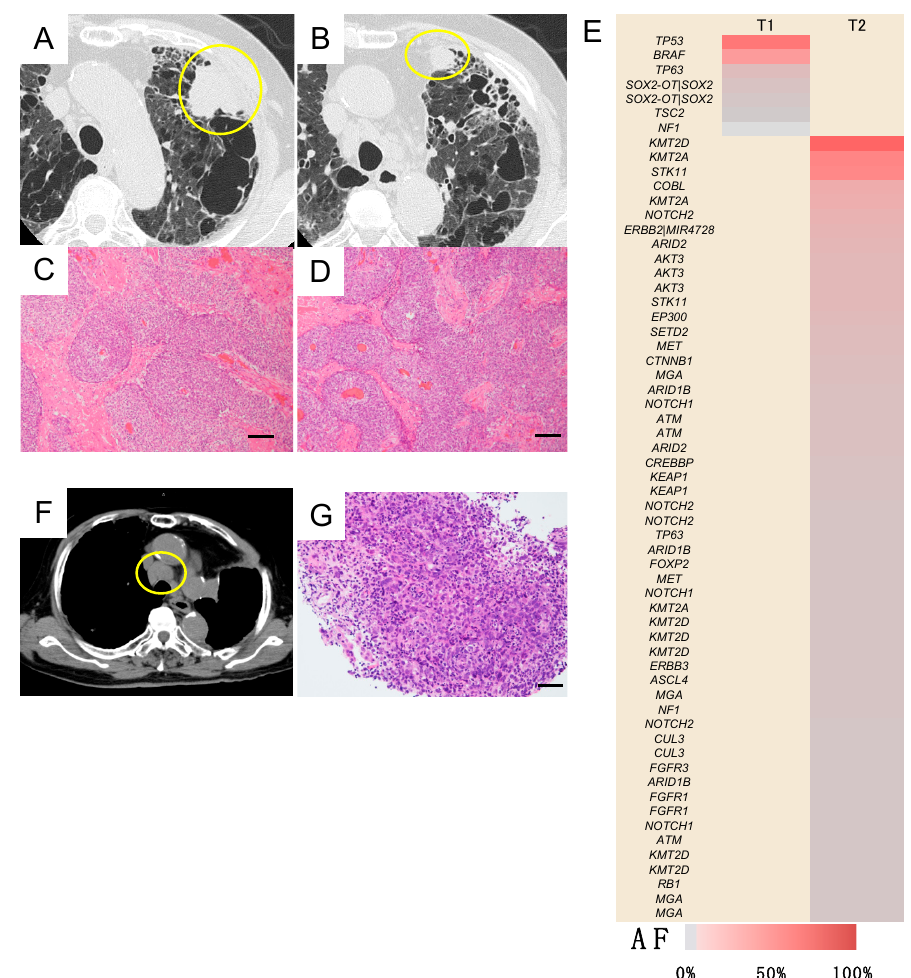
Figure 5. Radiological, histopathological and genomic findings in case C. ( A , B ) Two tumors, a large one (T1) and a small one (T2), were located in the left upper lobe in proximity to each other. ( C , D ) The tumors exhibited a similar histology of squamous cell carcinoma. Each scale bar indicates 100 µ m. ( E ) Heatmap of the gene mutations of the two lung tumors. The mutation profiles of T1 and T2 were completely different. ( F , G ) Postoperatively, tracheobronchial lymph node enlargement was observed and the tumor was identified as a squamous cell carcinoma. Each scale bar indicates 100 µ m. AF, allele fraction.